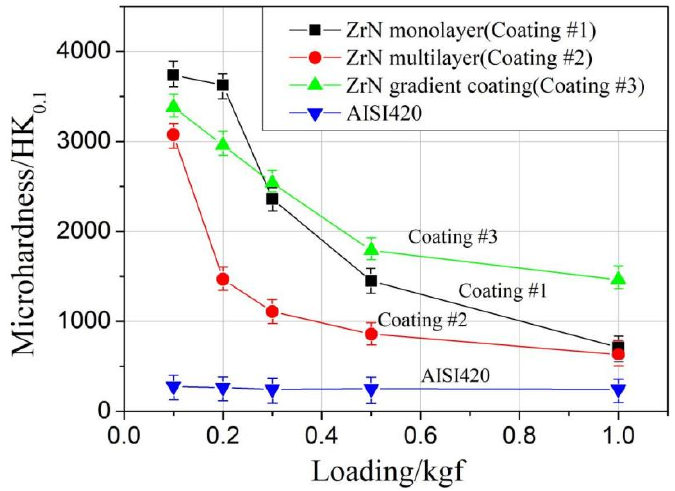
Figure 8. Surface microhardness profiles as a function of test loading.